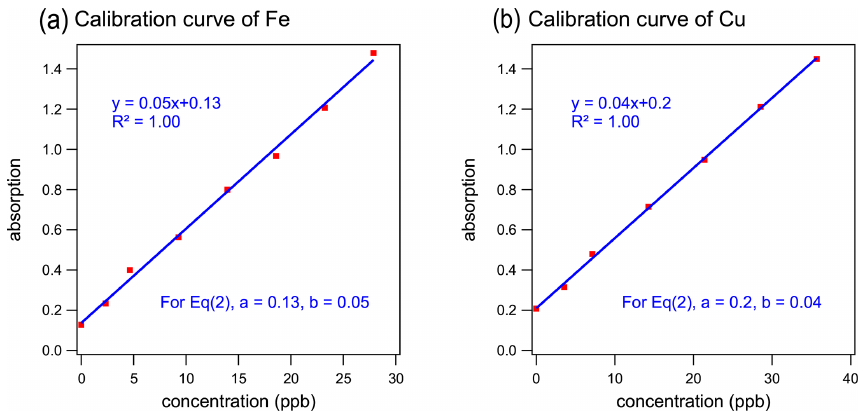
Figure 2. Calibration curves for (a) Fe(II) and (b) Cu(I) measurement by the LWCC system. Results of York regression are shown.